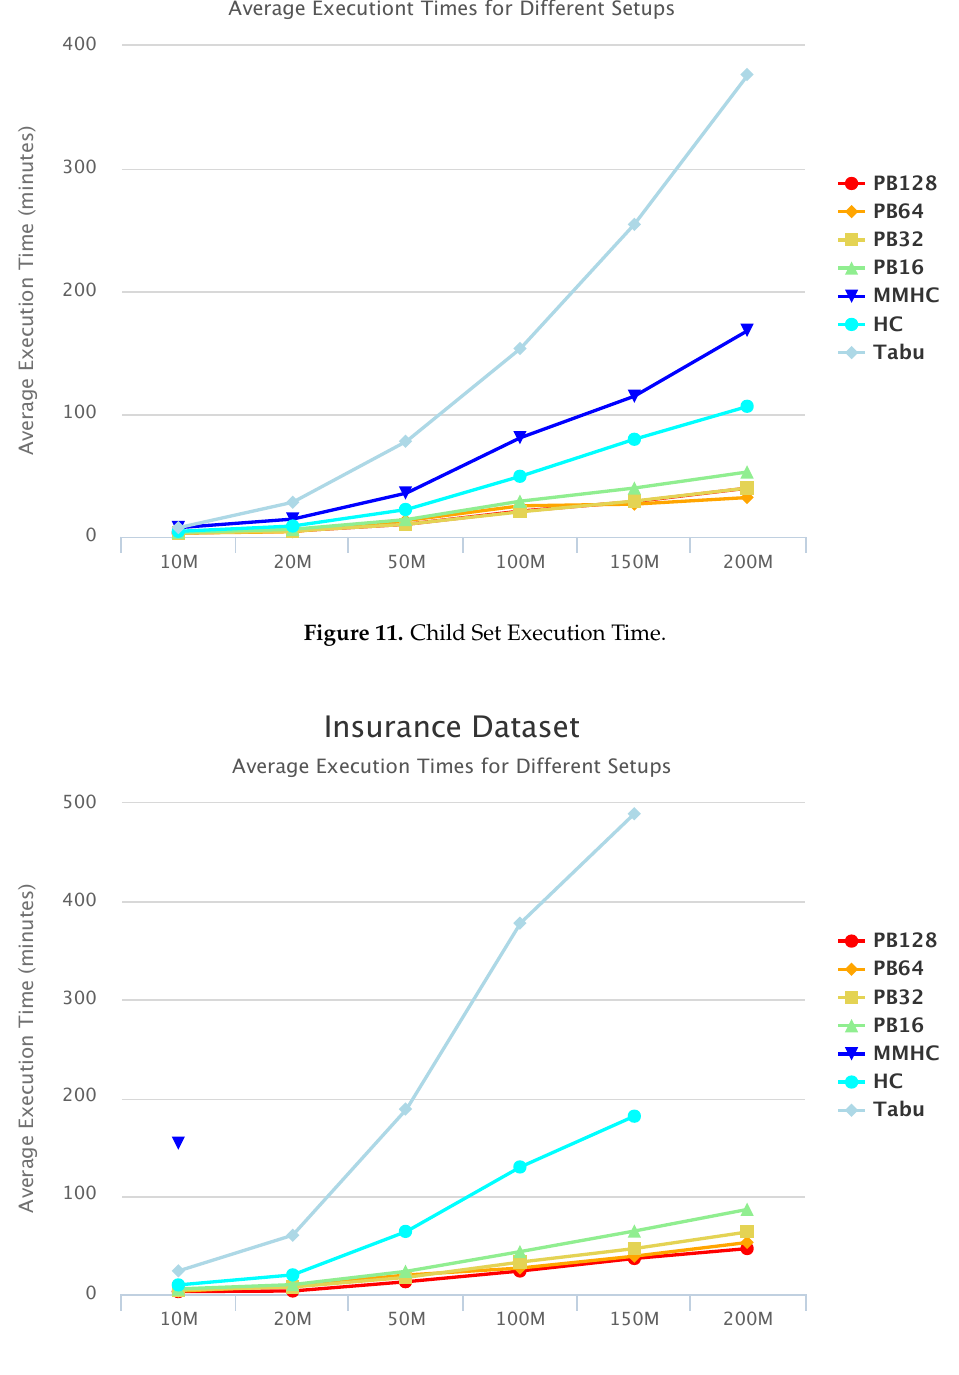
Figure 12. Insurance Set Execution